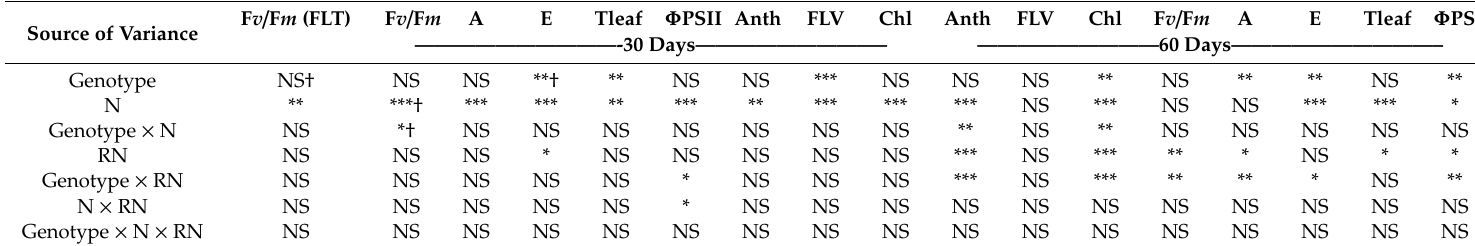
Table 2. Analysis of variance across four cotton genotypes, four nitrogen levels, and two reniform nematode levels and their interactions on physiological parameters at 30 and 60 days after